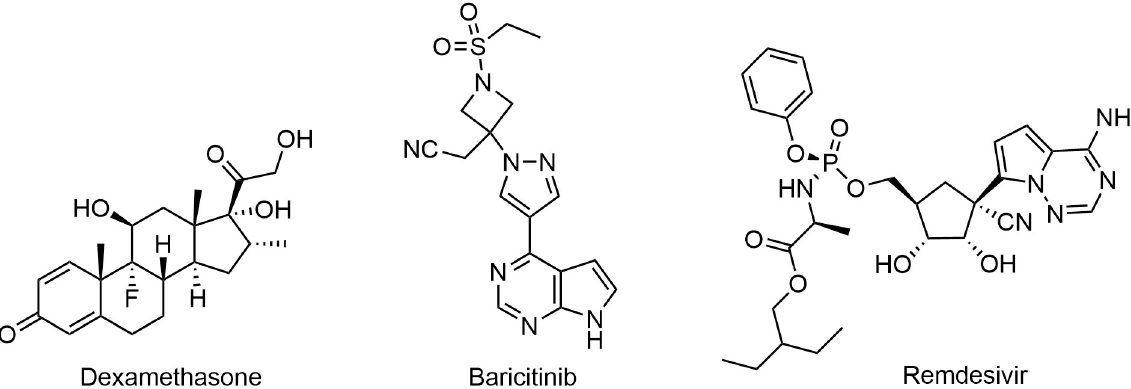
Fig 3. Chemical structure of considered reference drugs: (a) Dexamethasone (b) Baricitinib (c) Remdesivir.